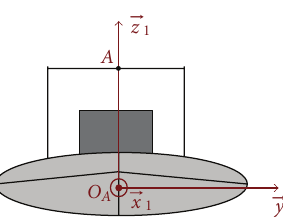
Figure 5: Local coordinate system for the ship in A , front view of the